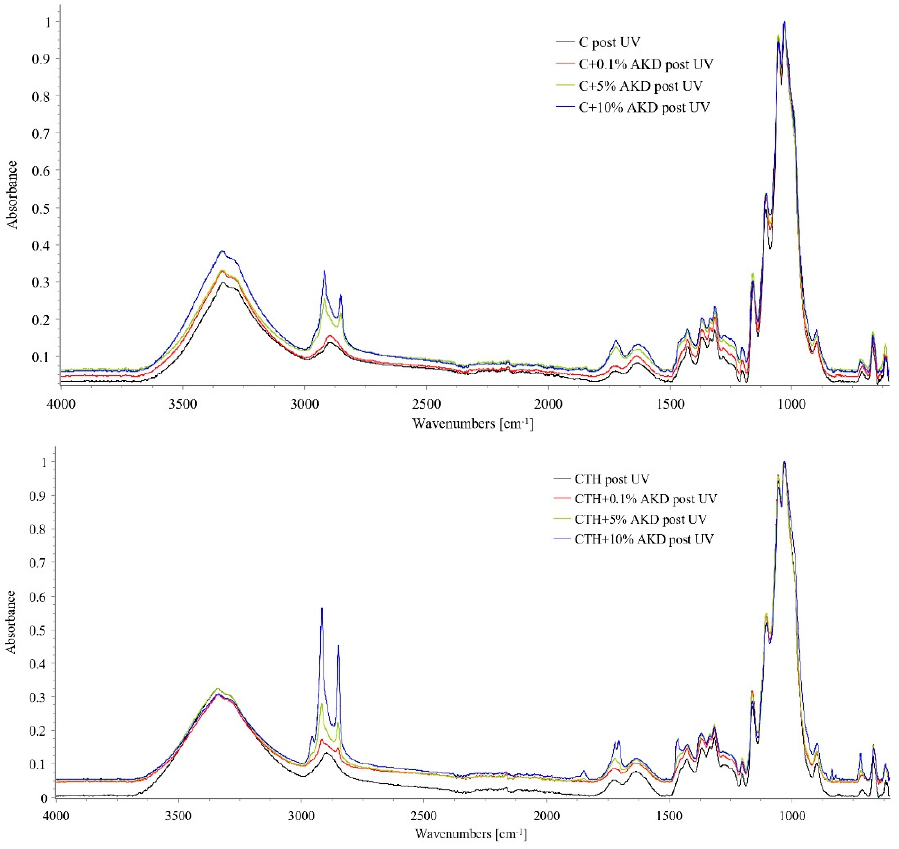
Figure 8. Comparison of FTIR spectra of unmodified ( top ) and thermally modified cedar wood samples ( bottom ) with AKD after the UV irradiation test.